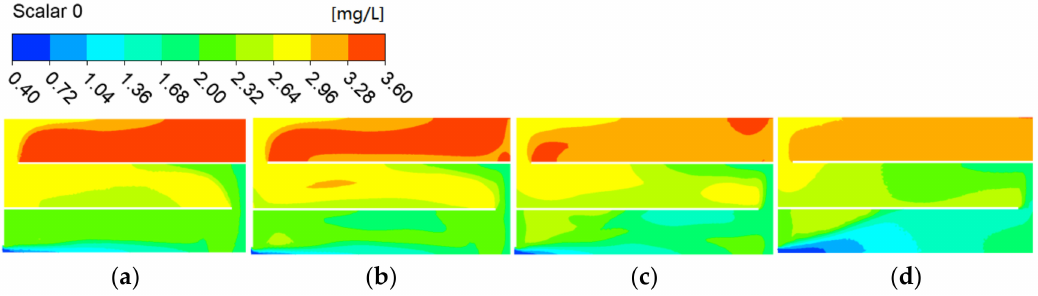
Figure 13. DO concentration contours of the oxic pool at different heights. ( a ) 0.95 H, ( b ) 0.63 H, ( c ) 0.3 H, ( d ) 0.05 H.